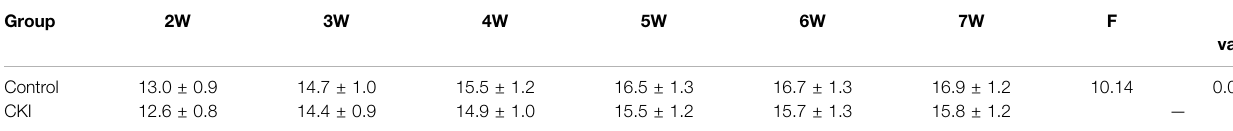
TABLE 2 | Patients have lower RISPAS scores in the CKI-treated group compared to control group (mean ± SD). Group 2W